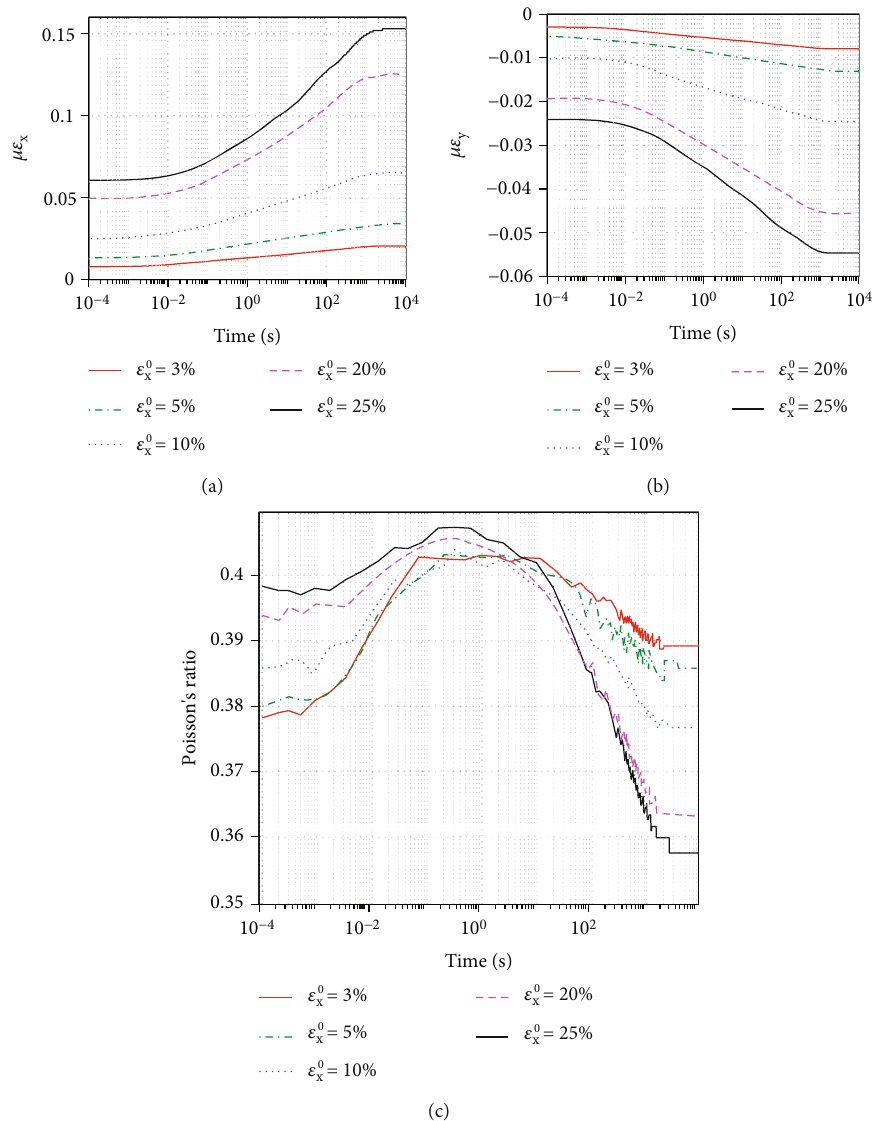
Figure 13: The curves of the (a) longitudinal strain, (b) transverse strain, and (c) Poisson ’ s ratio versus time under di ff erent fi xed strains when cohesive strength equals to